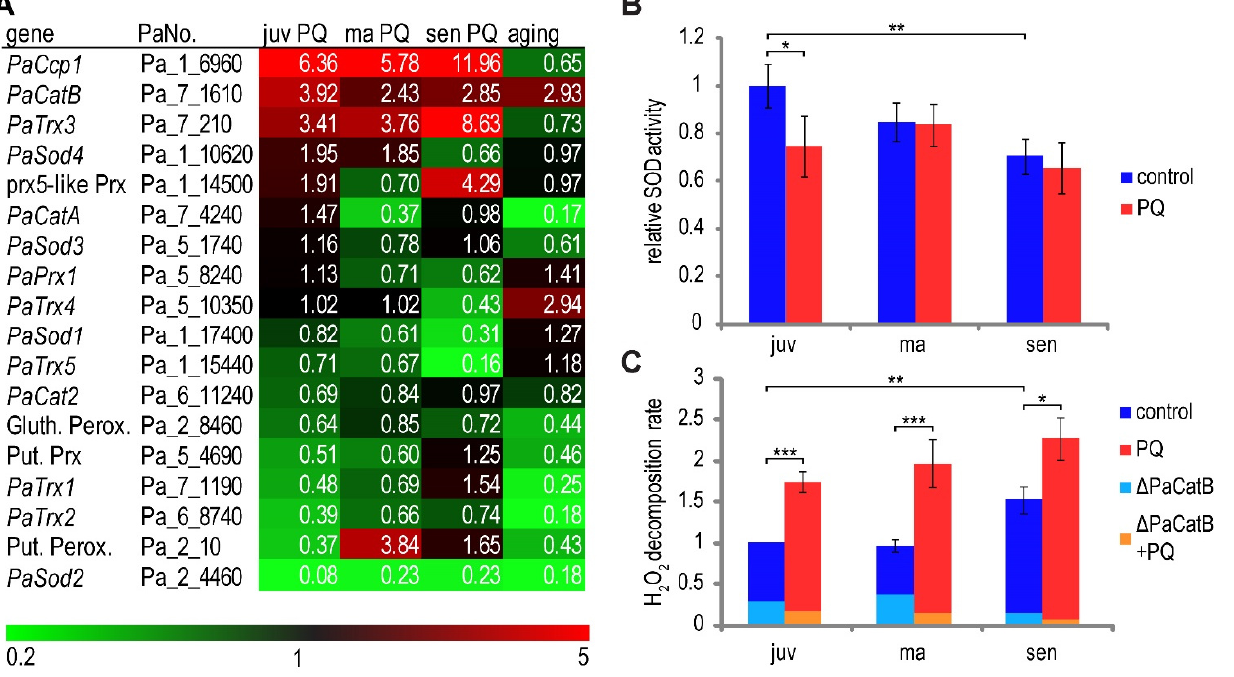
FIGURE 4: Effect of PQ-stress and aging on ROS-scavenging pathways . (A) Transcriptome data of ROS scavenger enzymes. Colors and num- bers indicate relative expression of transcripts of the indicated genes and treatment. Relative expression was calculated by dividing tpm of juvenile PQ-stressed samples by tpm of juvenile control (juv PQ), middle-aged PQ-stressed samples by middle-aged control (ma PQ), senes- cent PQ-stressed samples by senescent control (sen PQ) and senescent control by juvenile control (aging). (B,C) The overall SOD activity and H 2 O 2 decomposition rate were measured in protein extracts of juvenile (juv), middle-aged (ma) and senescent (sen) P. anserina cultures grown in PQ-free medium or in medium supplemented with 200 µM PQ. (B) Overall SOD activity is shown as mean relative expression to the juvenile wild type ± standard error. n = 6. Student’s t test p-values: juv to juv PQ pV = 0.049; juv to sen pV = 0.007. (C) Besides in wild-type strains (control and PQ), measurement of H 2 O 2 decomposition was carried out in a Δ PaCatB strain to estimate the portion of activity related to PaCATB. Data of wild type is shown as mean ± standard error. n = 9 - 11 for wt; n = 1 for Δ PaCatB . Student’s t-test p-values of wild type: juv to sen pV = 0.004; juv to juv PQ pV = 7.05E-5; ma to ma PQ pV = 2.41E-5; sen to sen PQ pV =